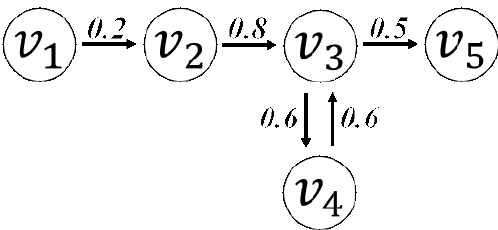
Figure 3. Converted weighted directed graph.